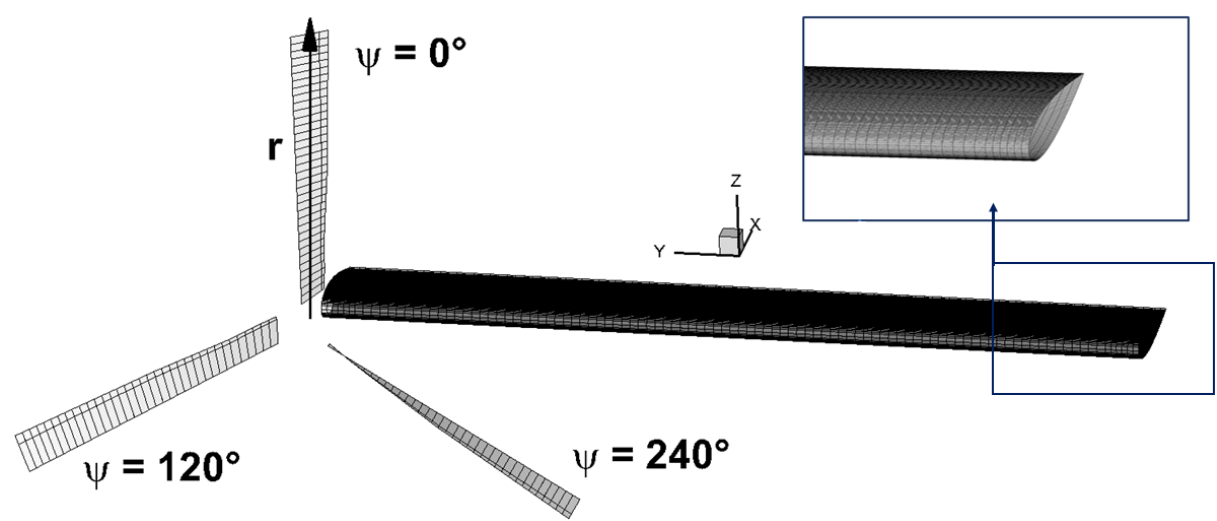
Figure 3. Layout of the numerical model of the wing/proprotor system; details of the surface mesh are shown in the zoomed inboard wing